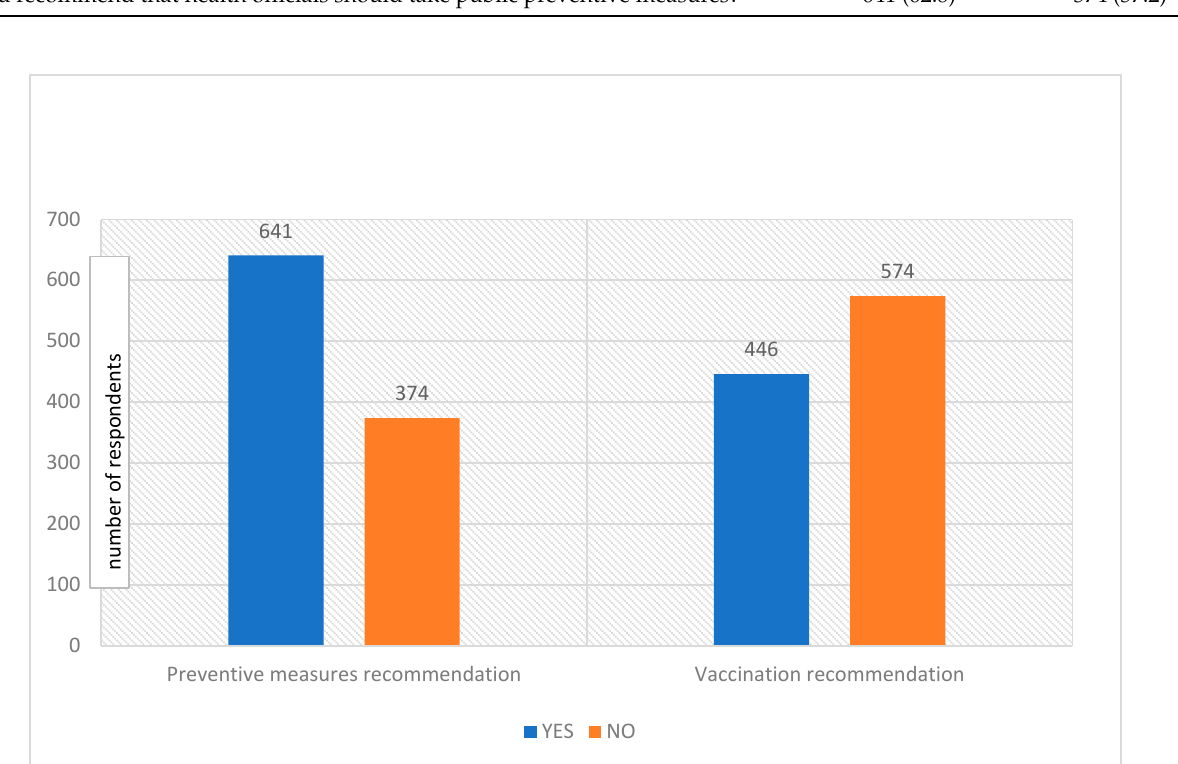
Figure 2. Public recommendations, preventive measures, and vaccination campaigns against monkeypox disease.